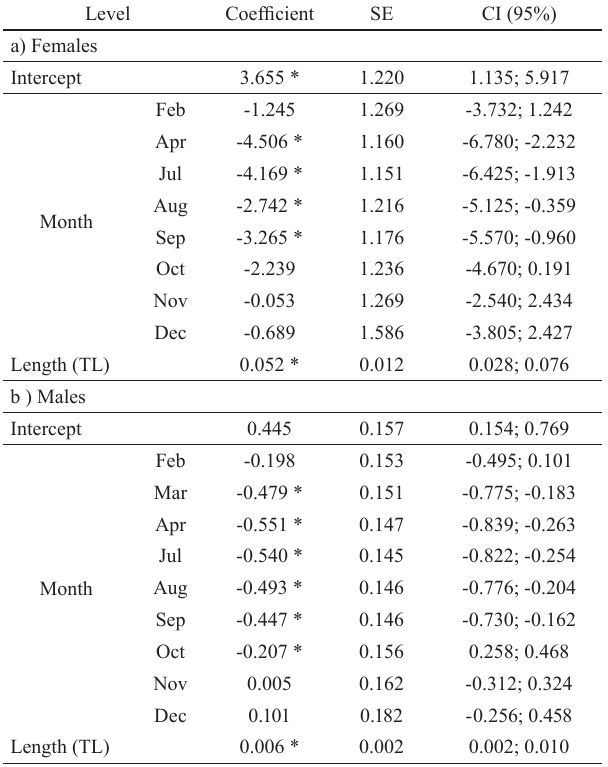
Table 3. Generalized least squares model coefficients, standard errors (SE) and 95% confidence intervals (CI) for the gonadosomatic index in females (a) and males (b) Pinguipes brasilianus . The asterisks indicate significant differences ( P <0.05) between each level and the reference level for each term included in the intercept estimate.